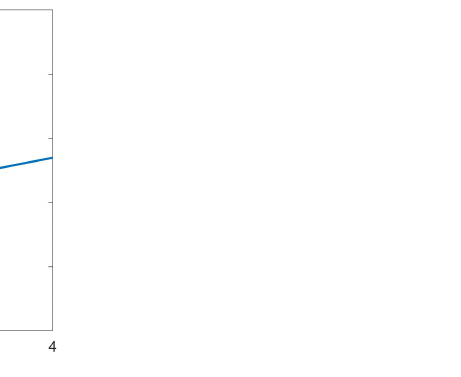
Figure 14. Percentage of the reduced cumulative magnetic induction intensity of multiple measure- ment